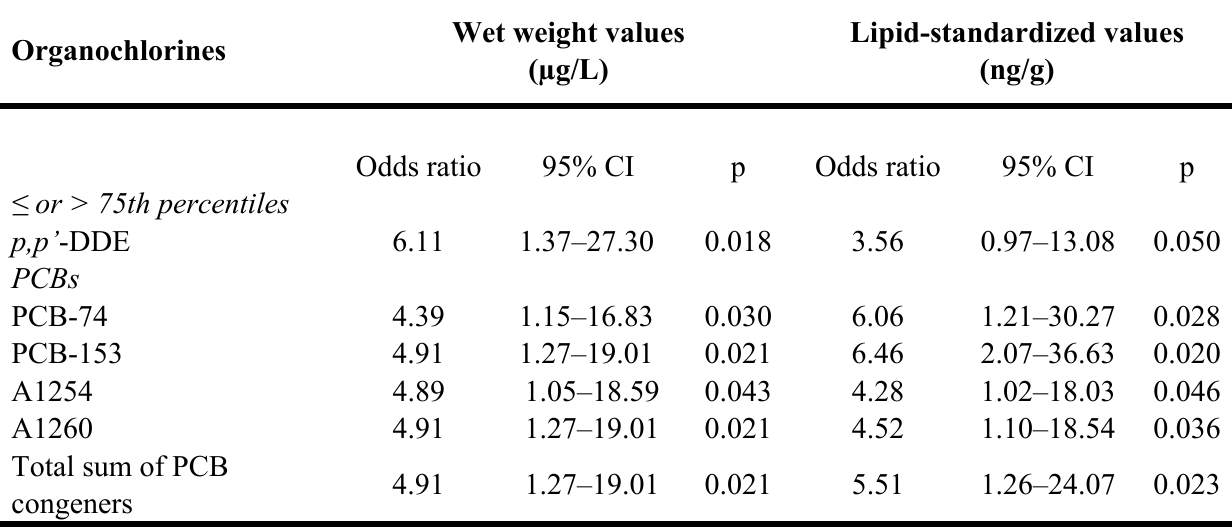
Table 2. Association between self-reported diabetes (Yes or No), wet weight and lipid-standardized values serum of p,p’ -DDE, individual PCB congeners PCB-74 and PCB-153, Aroclor 1254 and 1260, and total sum of PCB